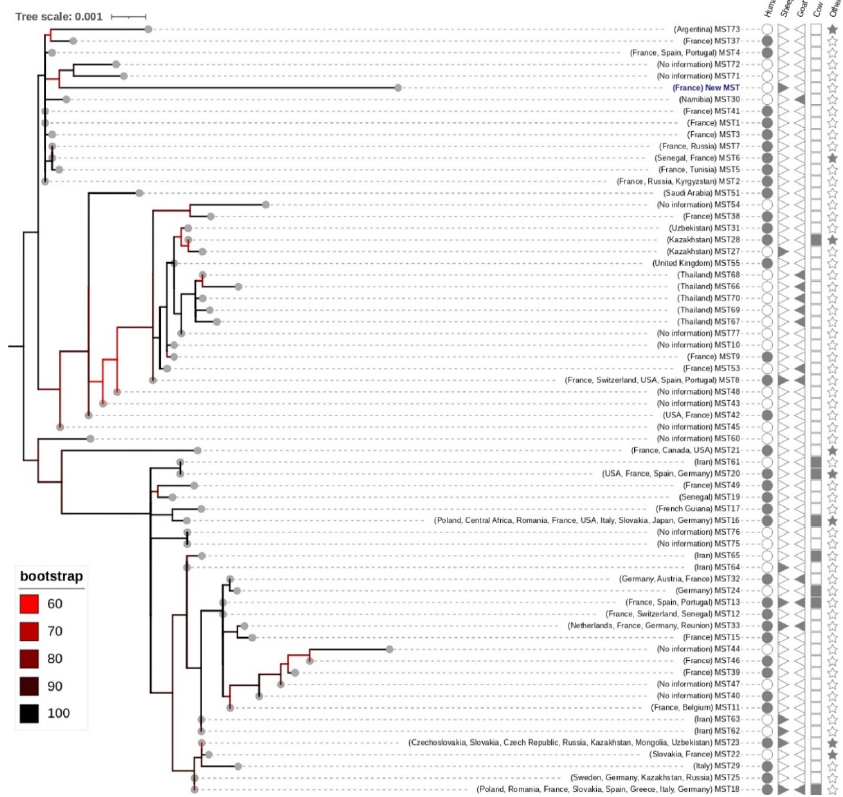
Figure 2. ML phylogeny showing the position of the new C. burnetii genotype obtained in the present study (blue label) among all available genotypes identified so far. The tree was generated using the ML method under 10,000 bootstrap replications. The tree involved 66 sequences type of 4,638 bp with 4% of informative sites. Geographical origin, host, and MS Id are indicated at each node. Branches are colour-coded according to bootstrap value. The tree is rooted at the midpoint.